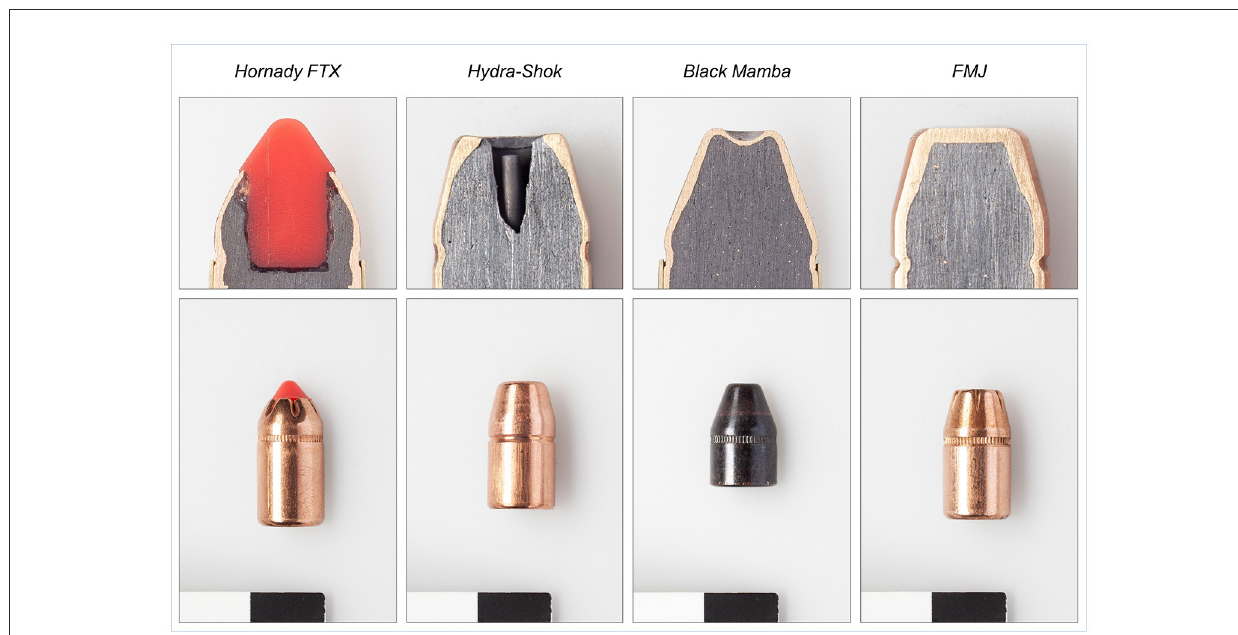
FIGURE1 The four different 9mm bullets evaluated in this study in terms of their injury potential when used with the BigBovid for stunning heavy cattle. Note the different design of the tip and the length of each bullet. The Black Mamba (110 gr) is shorter and has a lower mass than the Hornady (140 gr), the Hydra-Shok (158 gr), and the FMJ (158